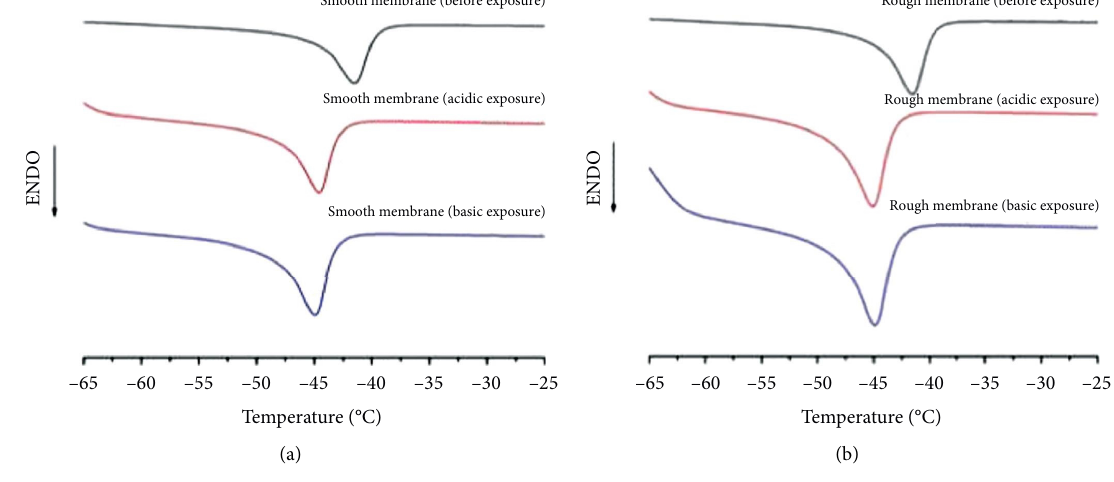
Figure 5: DSC curves for (a) smooth and (b) rough membranes. Table 1: Termal properties for samples as received and after acidic and basic degradation.